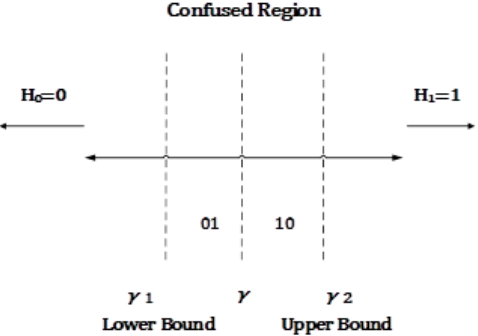
Figure 1. The double adaptive threshold detection scheme.